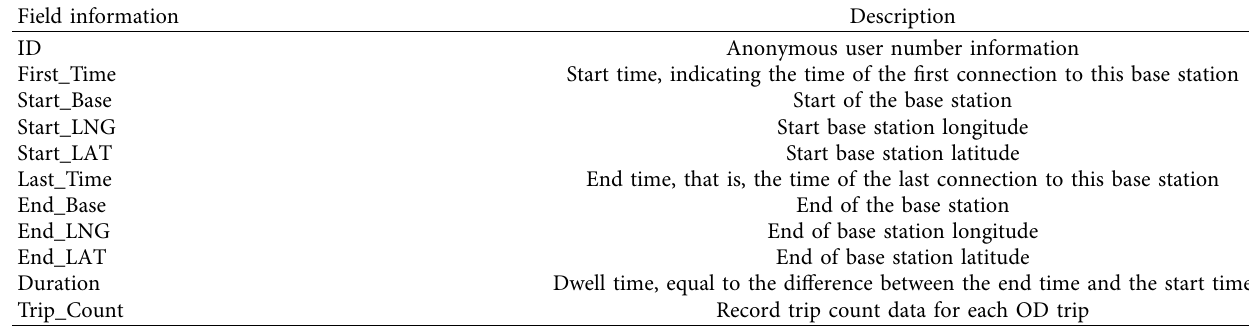
Table 4: Base station location and travel population data based on cellular signaling data.